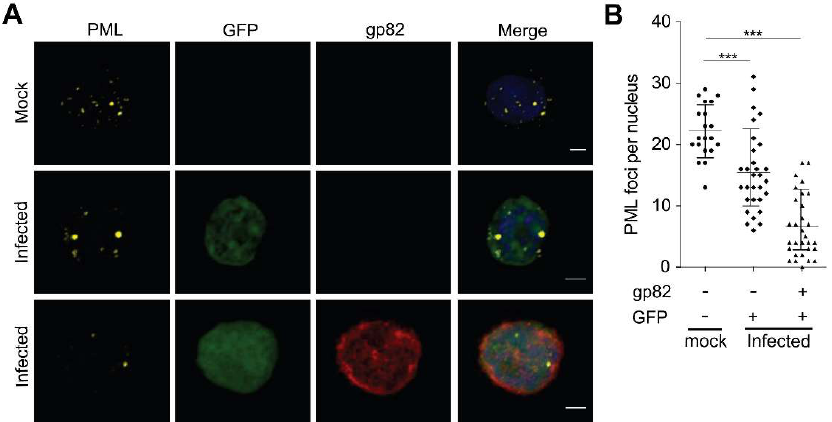
Figure 1. HHV-6A infection reduces the number of PML bodies. ( A ) HHV-6A-GFP and mock infected JJHan cells were immunostained for PML (yellow) and gp82 (red; late viral gene) and analyzed by confocal microscopy. Virus infected cells could be identified by GFP (green) and nuclei were stained with DAPI (blue). Representative images are shown for HHV-6A-GFP and mock infected cells. The scale bars correspond to 3 μm. ( B ) Quantification of PML foci in the nucleus of HHV-6A-GFP and mock infected JJHan cells ( n = 100). Infected cells were grouped by the stage of infection, where GFP is expressed during the early stage of infection, while both GFP and gp82 are expressed during late lytic replication. Results are shown as the mean of three independent experiments with standard errors (***, p < 0.001).